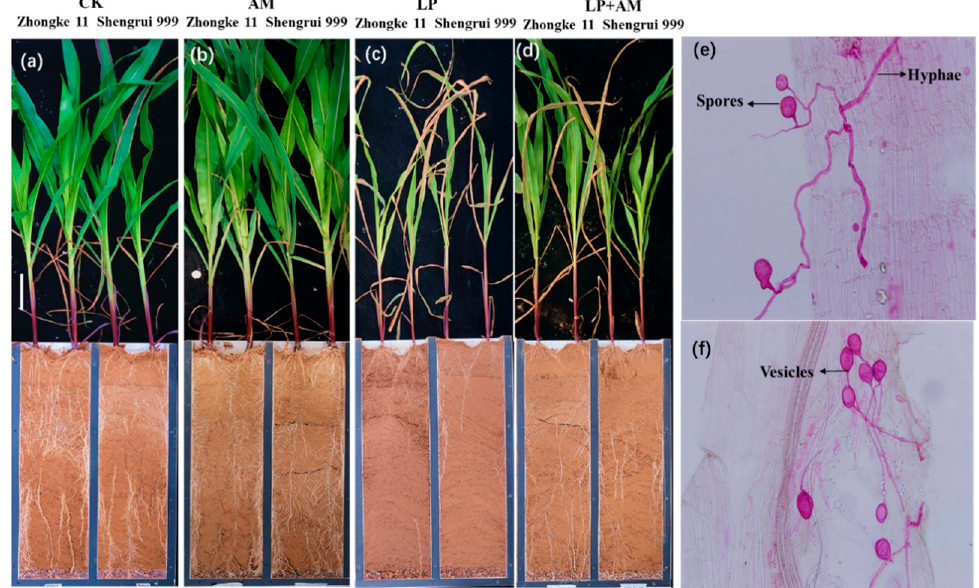
Figure 3. Example plant photos ( a–d ) and microscopy images of AM structure (spores, hyphae, vesicles, and arbuscules) stained with acid fuchsin ( e , f ) of two maize genotypes (Shengrui 999 and Zhongke 11) under four treatments that were grown in rhizoboxes for 53 days after transplanting. Note: ( a ), CK (optimal P, 200 mg kg − 1 ); ( b ), AM (optimal P + arbuscular mycorrhizal fungal inoculation); ( c ), LP (low P, no added P); ( d ), LP + AM (low P + arbuscular mycorrhizal fungal inoculation); ( e ) (Zhongke 11 under LP + AM); ( f ), (Shengrui 999 under